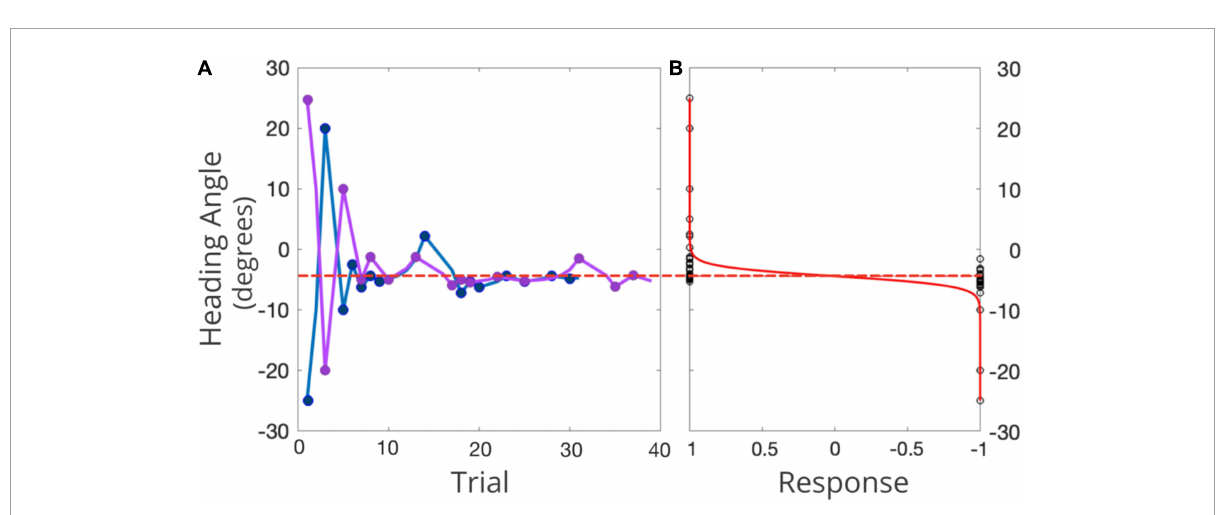
FIGURE4 (A) Example of two interleaved PEST staircases for one representative participant in one condition. The right-starting PEST is plotted in pink and the left-starting PEST in blue. 0 ◦ represents straight-ahead, with positive values representing rightward angles, and negative values leftward angles. The red dashed line represents the participants’ bias as inferred from the logistic function. (B) Black circles represent the participant’s response (1 = right, –1 = left) for each presented heading angle, in the solid red line is the fitted psychometric function. The dotted red line represents the midpoint of this function (i.e., participant’s perception of straight